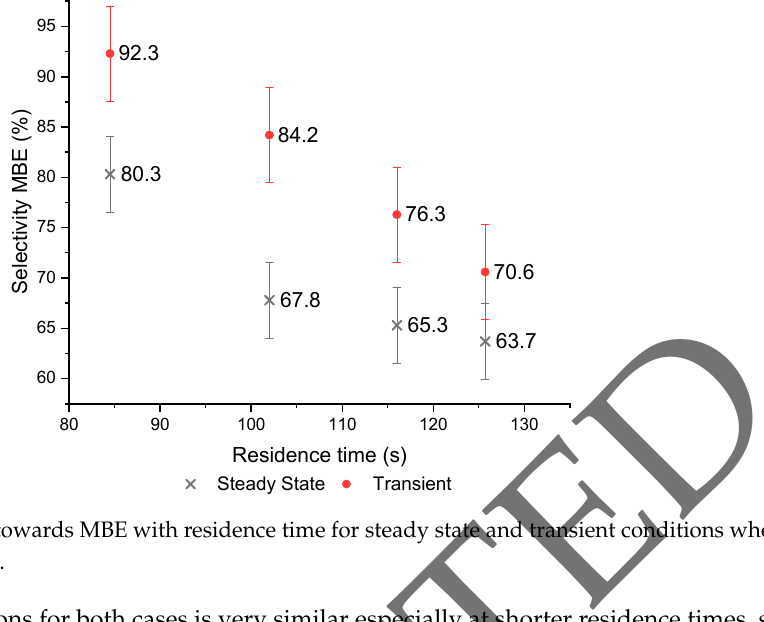
Figure 3. Selectivity towards MBE with residence time for steady state and transient conditions where A = 5 °C and τ = 75 s.